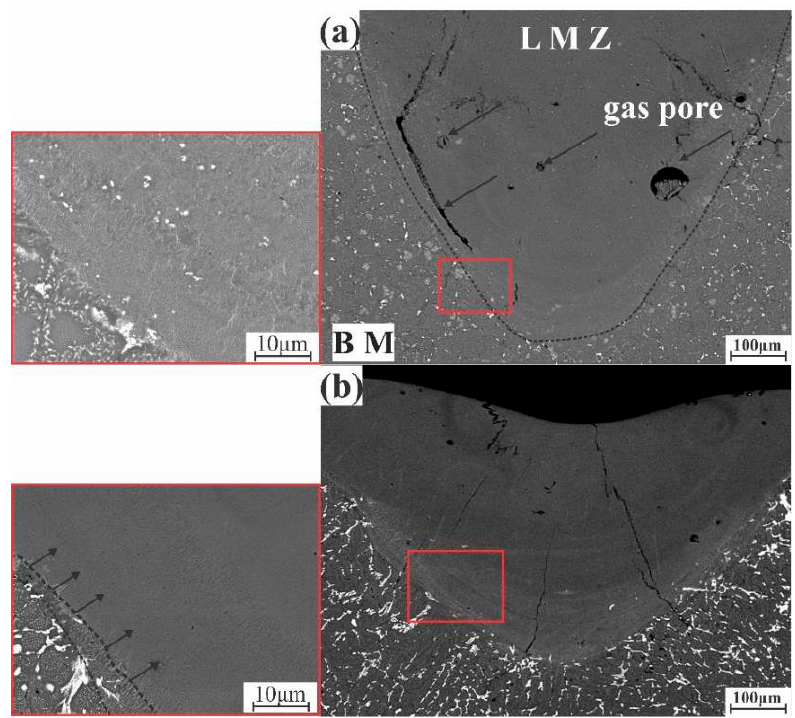
Figure 8. SEM images of the LMZ after homogenization annealing at 460 °C for 3 h: ( a ) AA7075-TiB, ( b ) AA7075-FeNi.